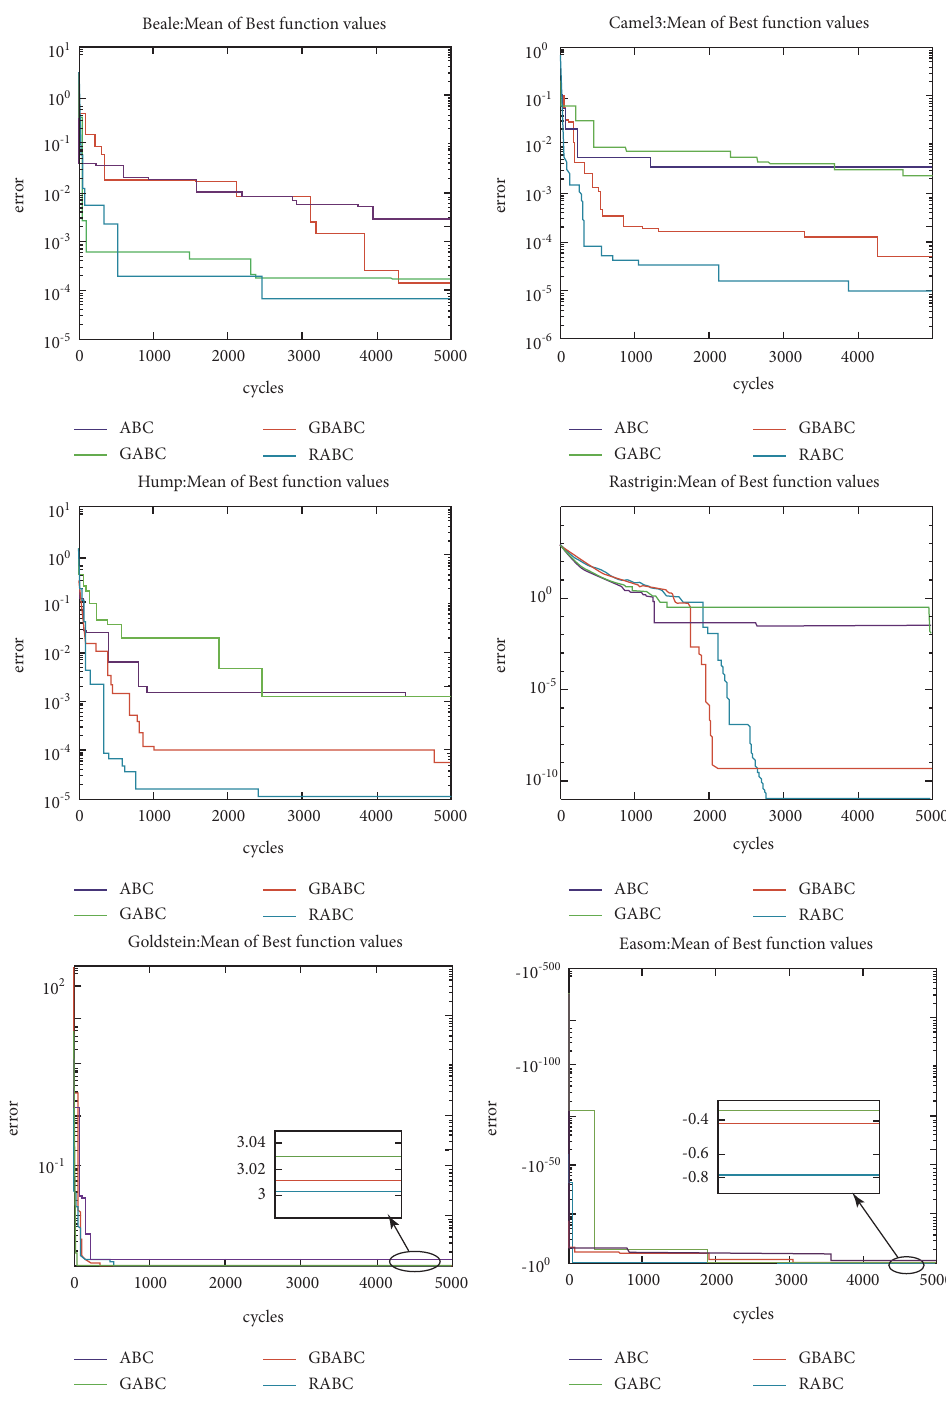
Figure 1: Convergence curve of benchmark